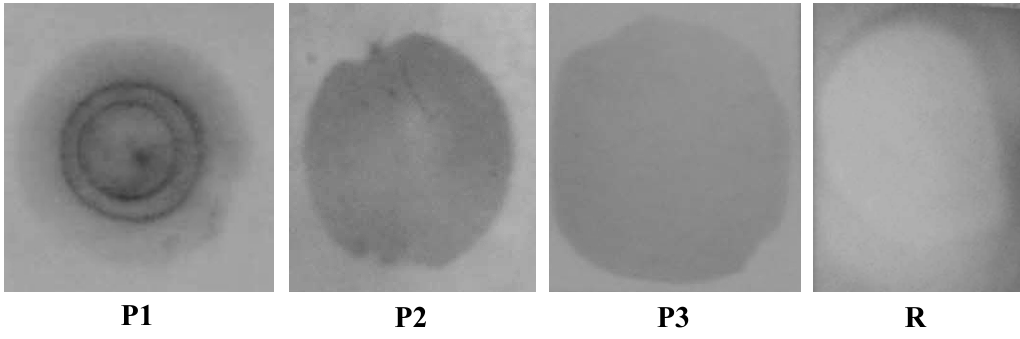
Figure 1. Hybridization colorimetric test on nylon membranes of Alexandrium Minutum complementary probes P1 (non labeled), P2 (thiol-labeled), P3 (biotin-labeled) and non complementary DNA R (random) with T1 complementary target